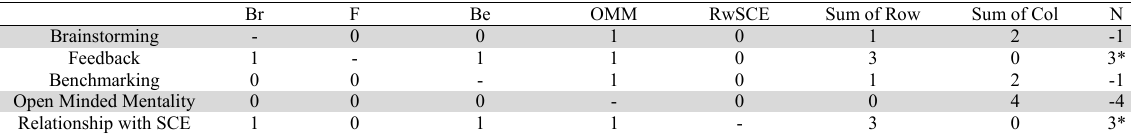
And the last steps are descending (Table 9 and Table 10) and ascend (Table 11 and Table 12) distillation matrices building, making comparison and deciding the final order. Descend distillation